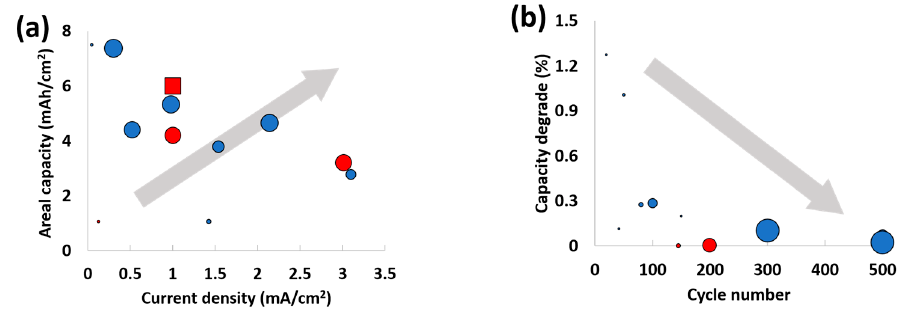
Figure 5. Ragone plots of ( a ) areal current density vs. areal capacity (mean of diameter: amount of sulfur loading) and ( b ) cycle number vs. capacity degrade (mean of diameter: C rate). Circle and square dots mean coin cell and pouch cell data, respectively. Dots in red represent data from this work. Table 1. Electrochemical performance of lithium–sulfur batteries with binder-free 3D electrodes in Figure 5.